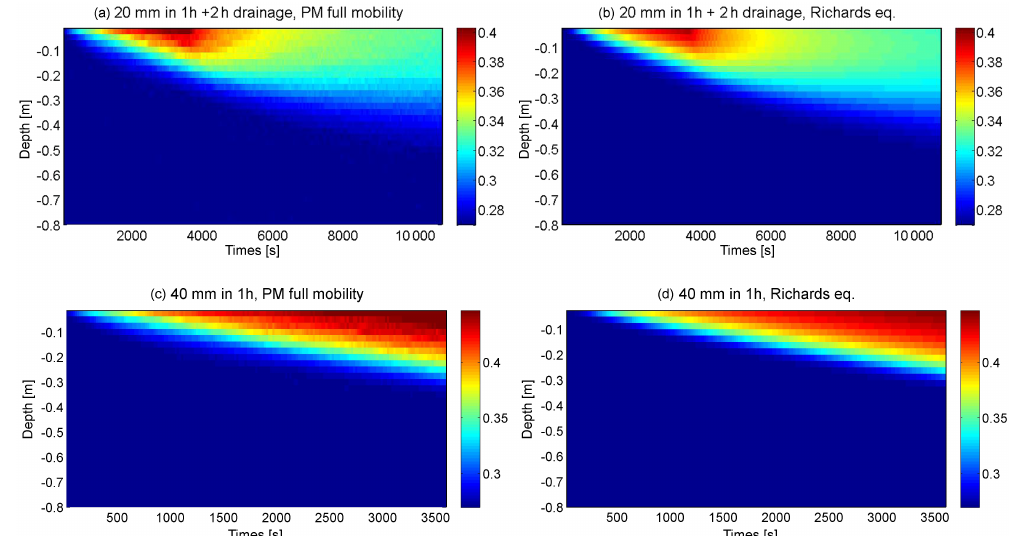
Figure 6. Time series of simulated soil moisture profiles in the upper 80cm of the young silty soil on schist for a block rain of 20mm and 2h of subsequent drainage ( a and b ) and a block rain of 40 mm in 1h ( c and d